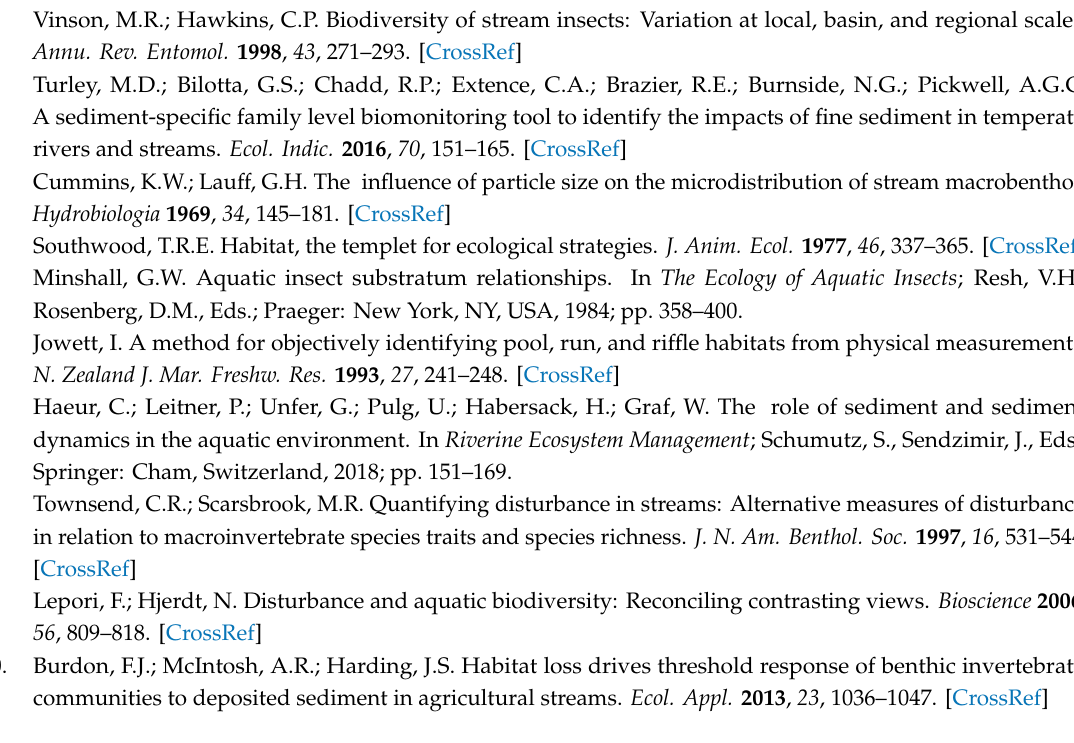
Table S7: Best identified random e ff ect and p values from linear mixed e ff ect model analysis of the relationships of macroinvertebrate community response variables physical characteristics of sediment within eight agricultural headwater streams in Indiana, Michigan, and Ohio. Figure S1: Map depicting the locations of sampling sites in the Saint Joseph River watershed, Indiana and Michigan. Figure S2: Map depicting the locations of sampling sites in Upper Big Walnut Creek watershed in Ohio. Figure S3: Depiction of stratified random sampling scheme used for collecting sediment